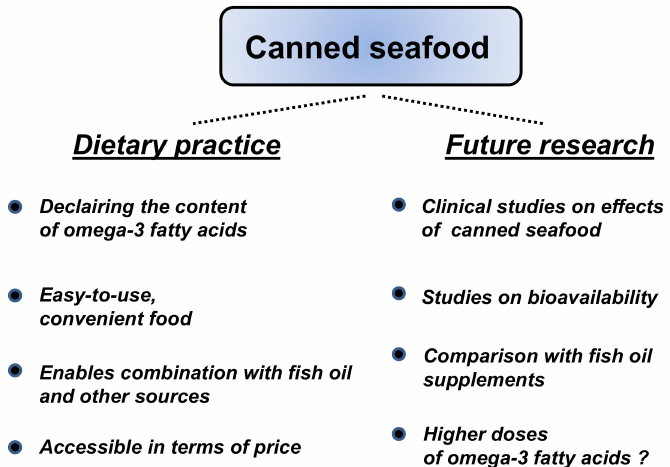
Figure 3. Suggestions of canned seafood being suited to dietary practice and future